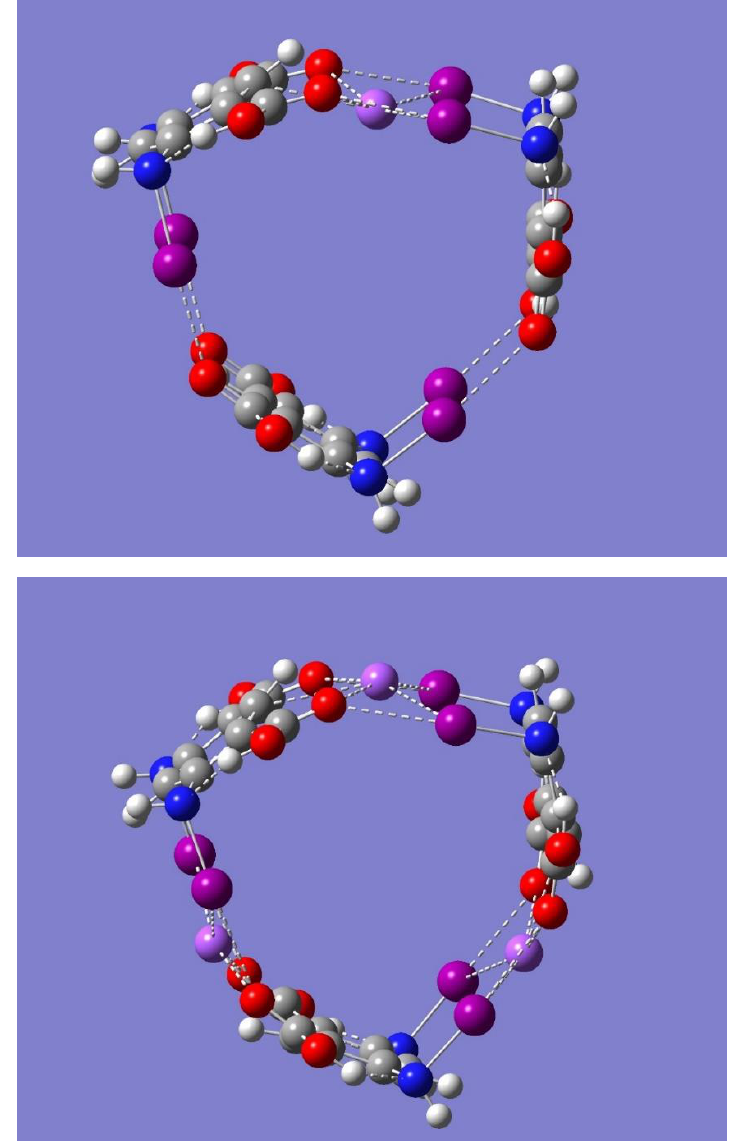
Figure 7. Electrostatic potential on the 0.001-au molecular surface of the optimized trimer system. Yellow-red represents the most negative electrostatic potential and blue the most positive.